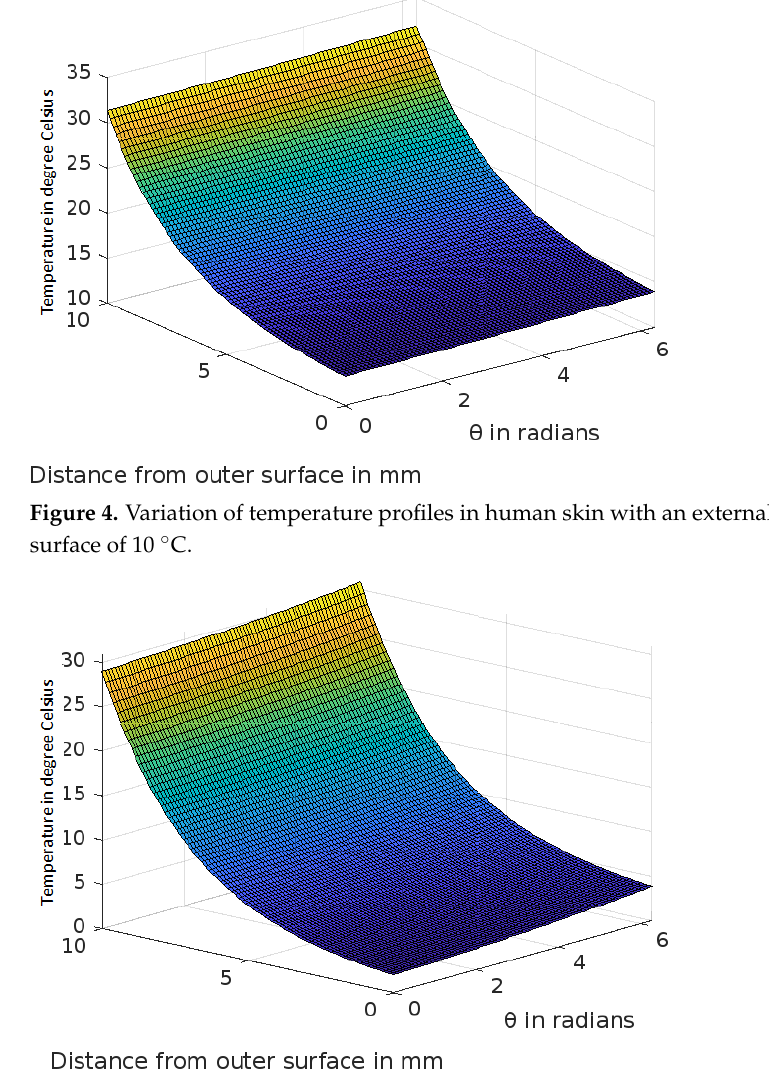
Figure 5. Variation of temperature profiles in human skin with an external temperature at the skin surface of 0 ◦